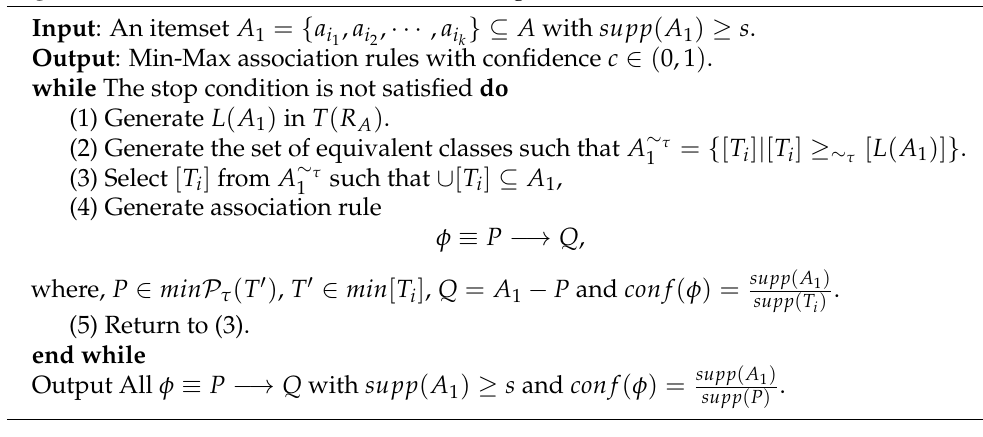
Algorithm 2 Min-Max association rules mining from a fixed itemset